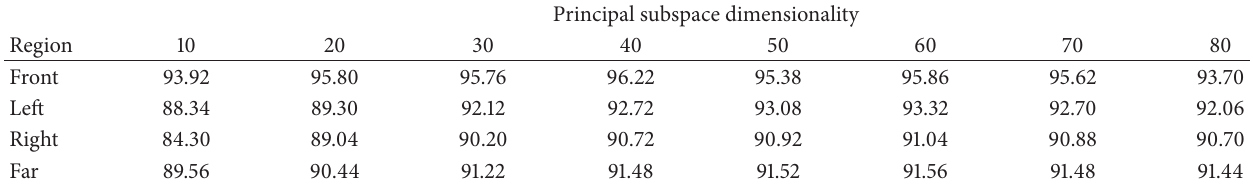
Table 1: Accuracy for the different regions as a function of the principal subspace dimensionality. Principal subspace dimensionality